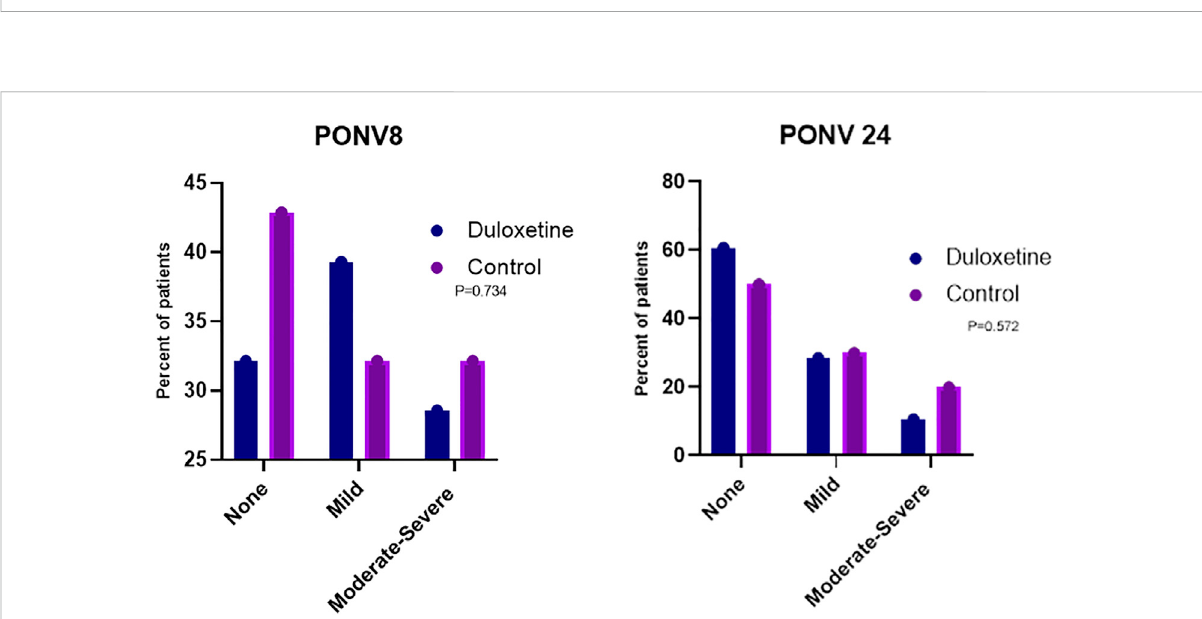
FIGURE 4 Percentage of patients inthe two groups who developed nausea and vomiting with different severities at8 (PONV 8) and 24 h (PONV 24) post-